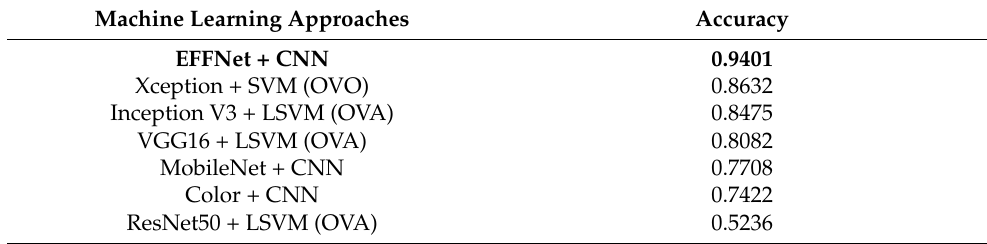
Table 18. The highest accuracy based on feature representation for Sabah Food Dataset.